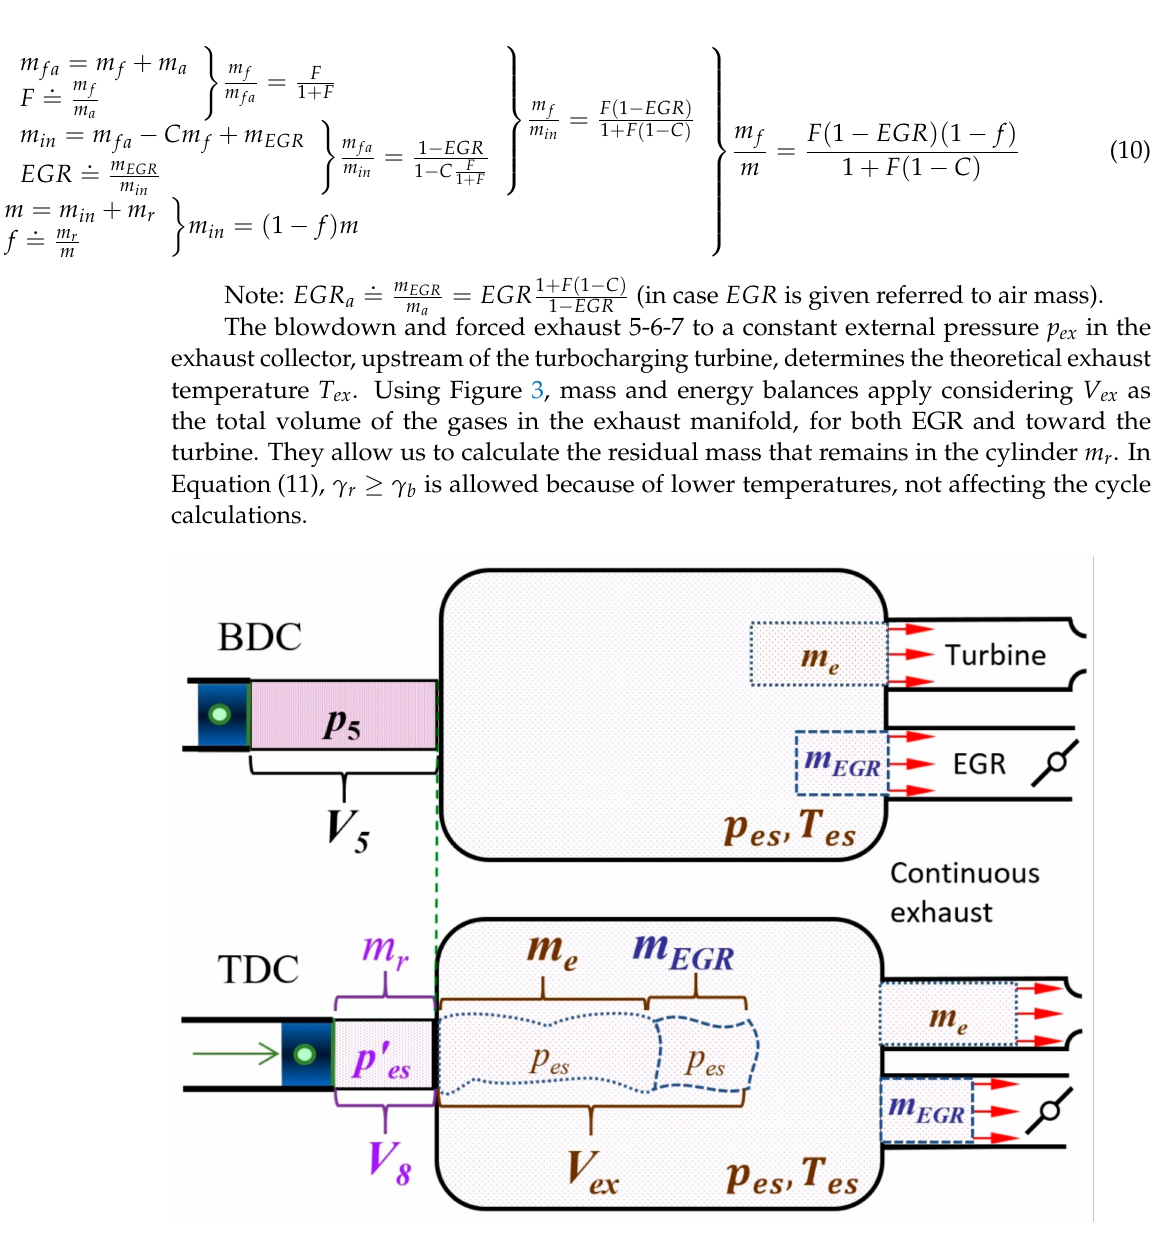
Figure 3. Control volumes and variables during the exhaust process. Above, initial; below,